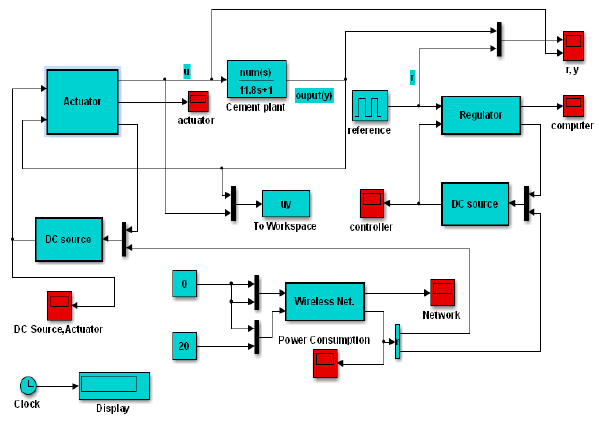
Fig. 9. The WCN scheme for ESP using Truetime.